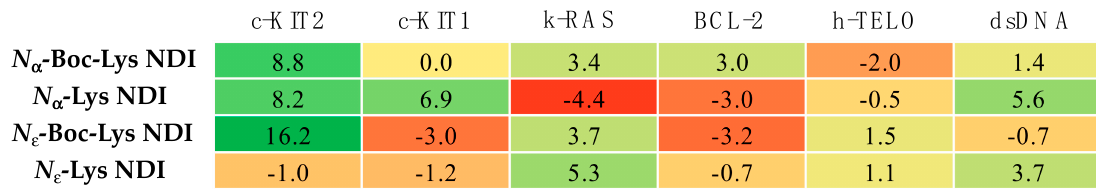
Figure 8. Heat map of the differential stabilization of the studied DNA sequences by the NDI enantiomers. The values represent the difference between the Δ T m for the L -enantiomer and the Δ T m for the D -enantiomers with each oligonucleotide. Different concentrations were used for N ε -Lys NDIs (150 μ M for L -NDI and 75 μ M for D -NDI); DNA concentration was kept similar for all measurements. All the values are in ° C as determined from VT CD studies.